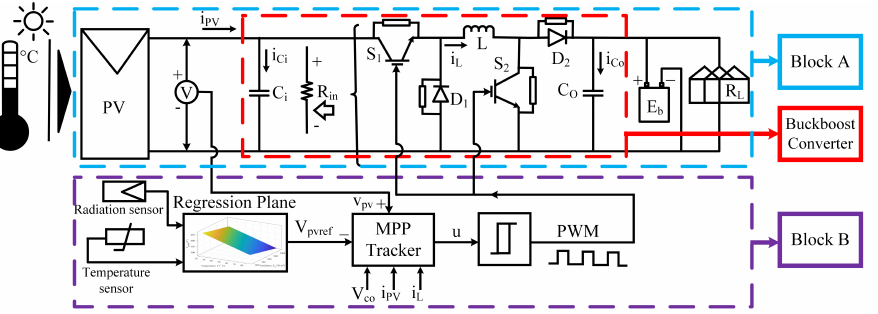
Figure 4. Complete model of PV